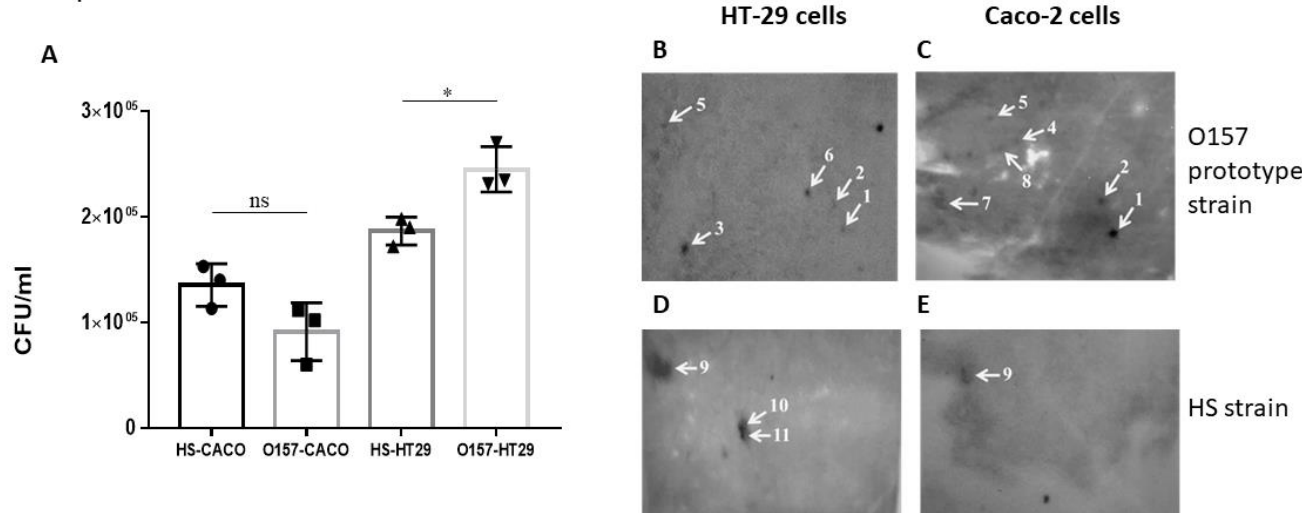
Figure 1. Identification of proteins involved in VTEC and commensal E. coli attachment to gastroin- testinal cells by a cell blot approach. ( A ) Comparison of attachment of NCTC12900 and HS E. coli strains to gastrointestinal epithelial cells. Data represent mean ± SEM of three independent experi- ments of each bacterial strain and gastrointestinal cell line. * Statistical analysis performed using one-way ANOVA with Sidak’s multiple comparison test. (ns: indicates not statistically significant); ( B – E ) Representative cell-probed blots prepared from O157:H7 NCTC 12900 ( B , C ) and the commensal E. coli HS ( D , E ) cells. Blots were probed with 1 × 10 6 cells/mL HT29 ( B , D ) or Caco-2 ( C , E ) cells, respectively. Identified proteins are highlighted with white arrows, and numbers correspond to those listed in Table 1.